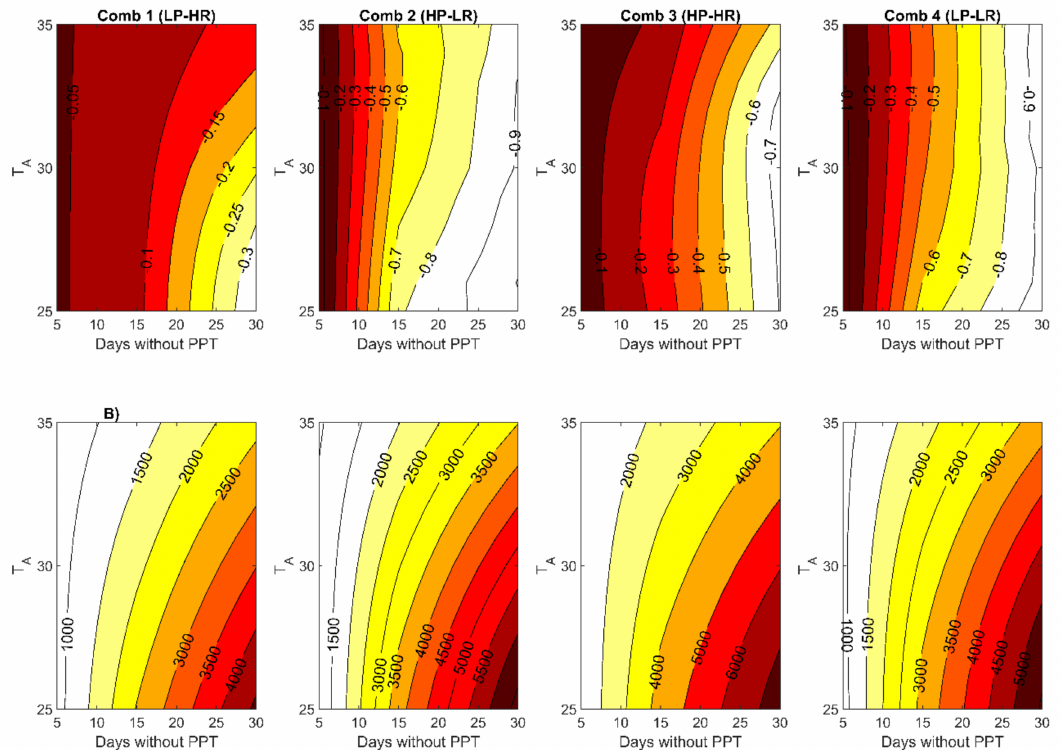
Figure 5. Soil water potential (upper panels; MPa) and cumulated net assimilation (lower panels; µ mol m –2 s –1 ) for each focal trait combination (Table 2) for specific T A (y-axis) and after a certain number of consecutive days without precipitation (x-axis). The baseline temperature corresponds to the warmest day in 2005. The rest of the growing conditions correspond to those observed in the study site during the same period within the growing season of